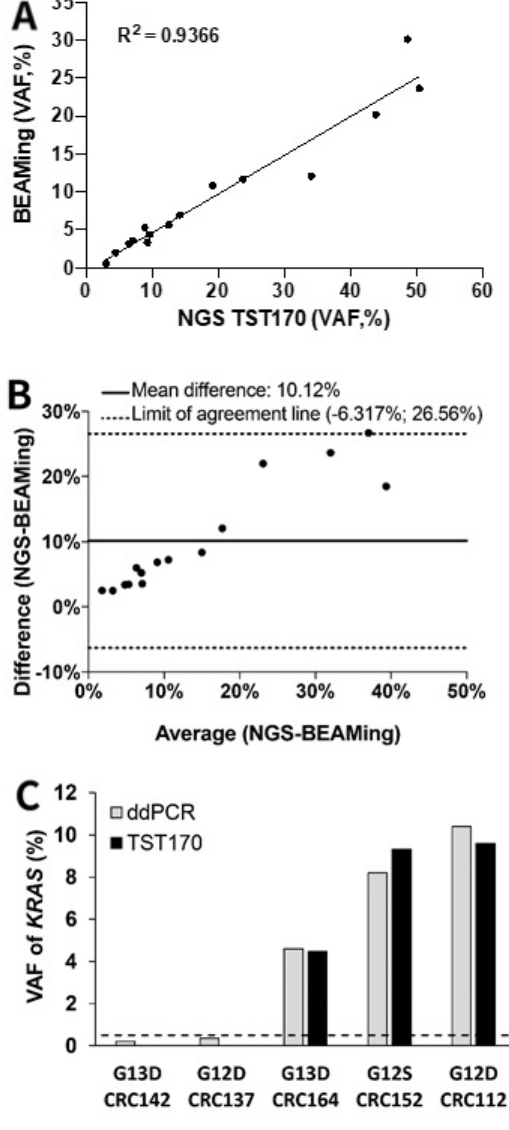
Figure 4. TST170 and digital PCR analysis for KRAS variants in cfDNA. ( A ) Linear regression analysis of KRAS VAFs in cfDNA analyzed by TST170 and BEAMing. ( B ) Bland–Altman plot of the KRAS VAFs between TST170 and BEAMing. ( C ) Validation of the KRAS status by ddPCR in cfDNA samples with discordant results between TS170 analysis and BEAMing or tumor tissue status. The dotted line represents a VAF ≥